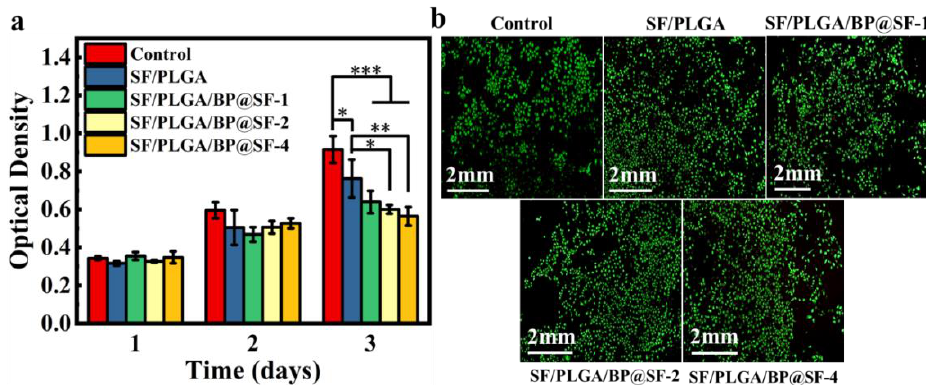
Figure 5. Biocompatibility of electrospinning membrane. ( a ) Evaluation of cell viability by CCK-8 assay; ( b ) LIVE/DEAD cell staining of L929 cells on the third day of culture. *P < 0.05, **P < 0.01, ***P < 0.001, data represent means ± SD.